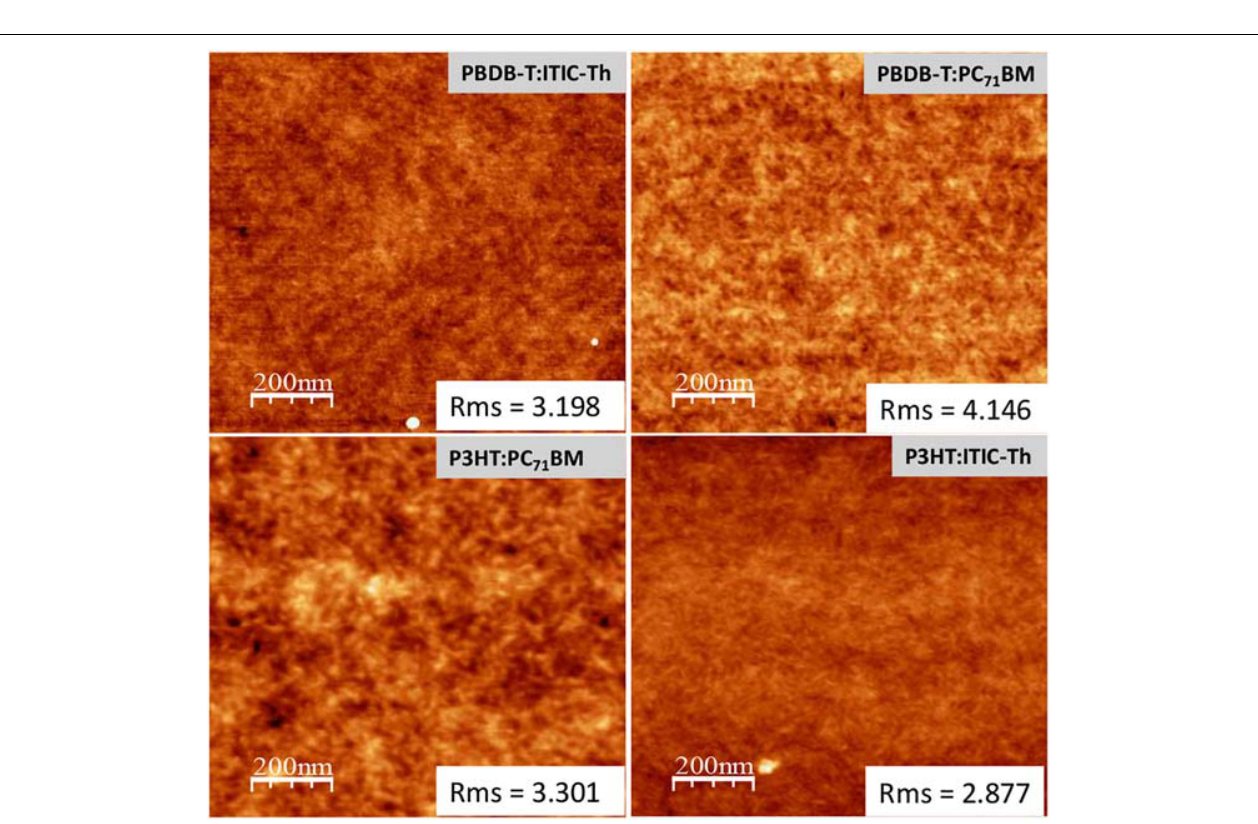
FIGURE 11 | FTIR spectra of various organic blends. Inset is a comparison of P3HT:ITIC-Th with the pristine components.